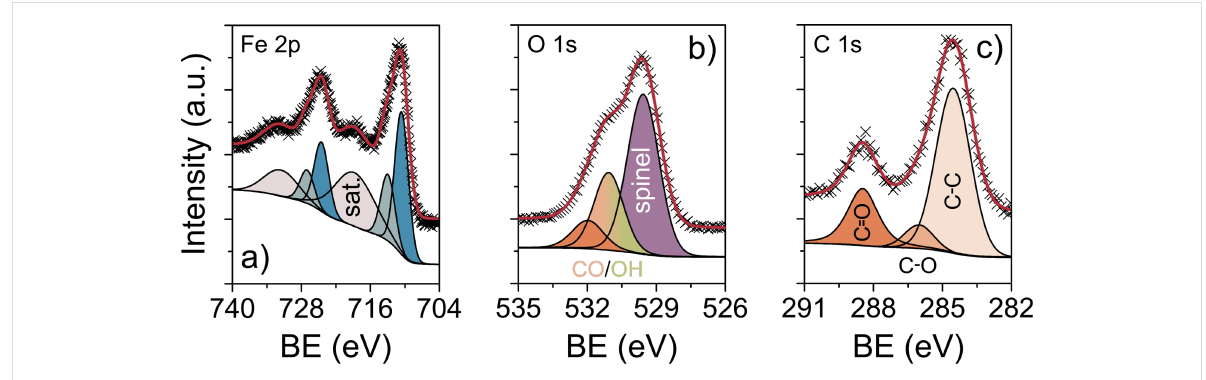
Figure 3: XPS spectra of the (a) Fe 2p, (b) O 1s and (c) C 1s core levels of as-prepared ZFO nanoparticles. The peaks in gray, blue, violet and orange/green correspond to tetragonal Fe 3+ , octahedral Fe 3+ , lattice oxygen as well as hydroxyl oxygen and different organic compounds containing carbon–oxygen functionalities. The red lines are the sum of the peak fits.